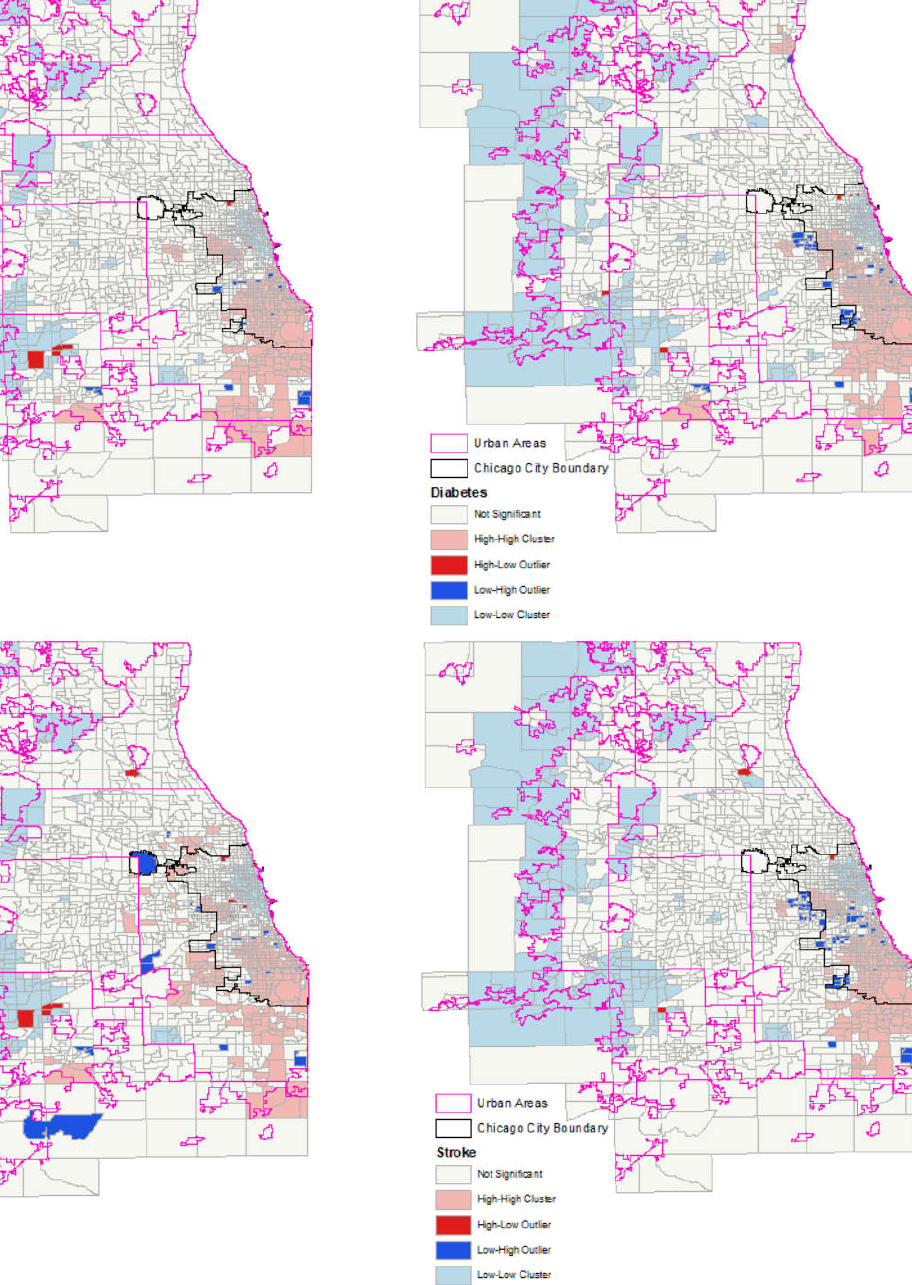
Figure 1. The clusters and outliers of hypertension, diabetes, coronary heart disease, and stroke.